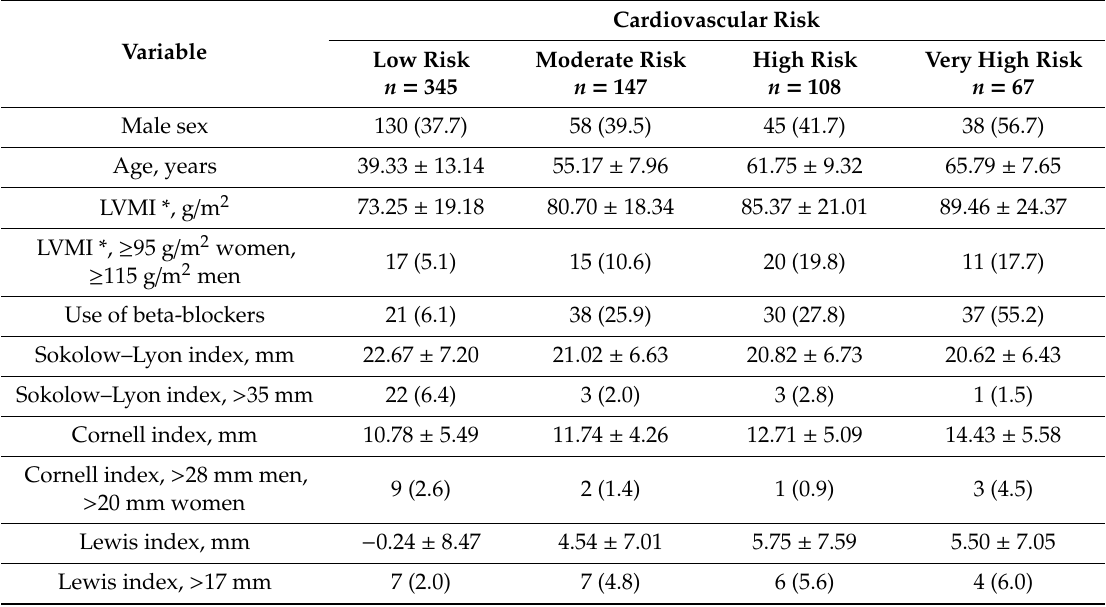
Table 2. Characteristics of the population according to cardiovascular risk.